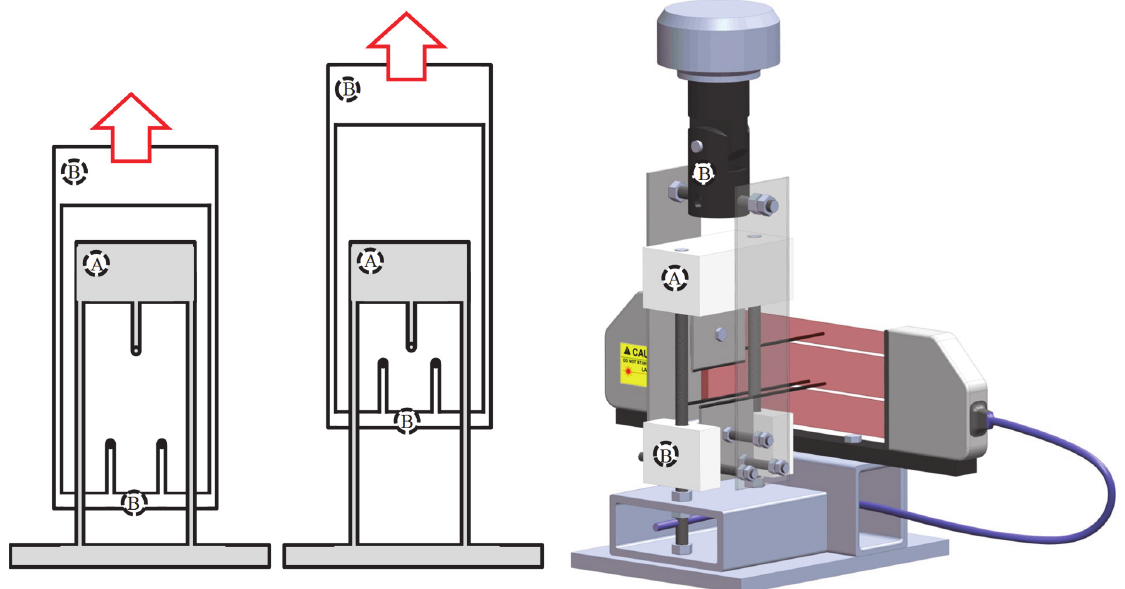
Figure 1: The custom device that was used to perform three point bending tests with a tension only load cell. The device comprises two parts: (A) which was fixed to the load frame's base and (B) which was attached to its movable